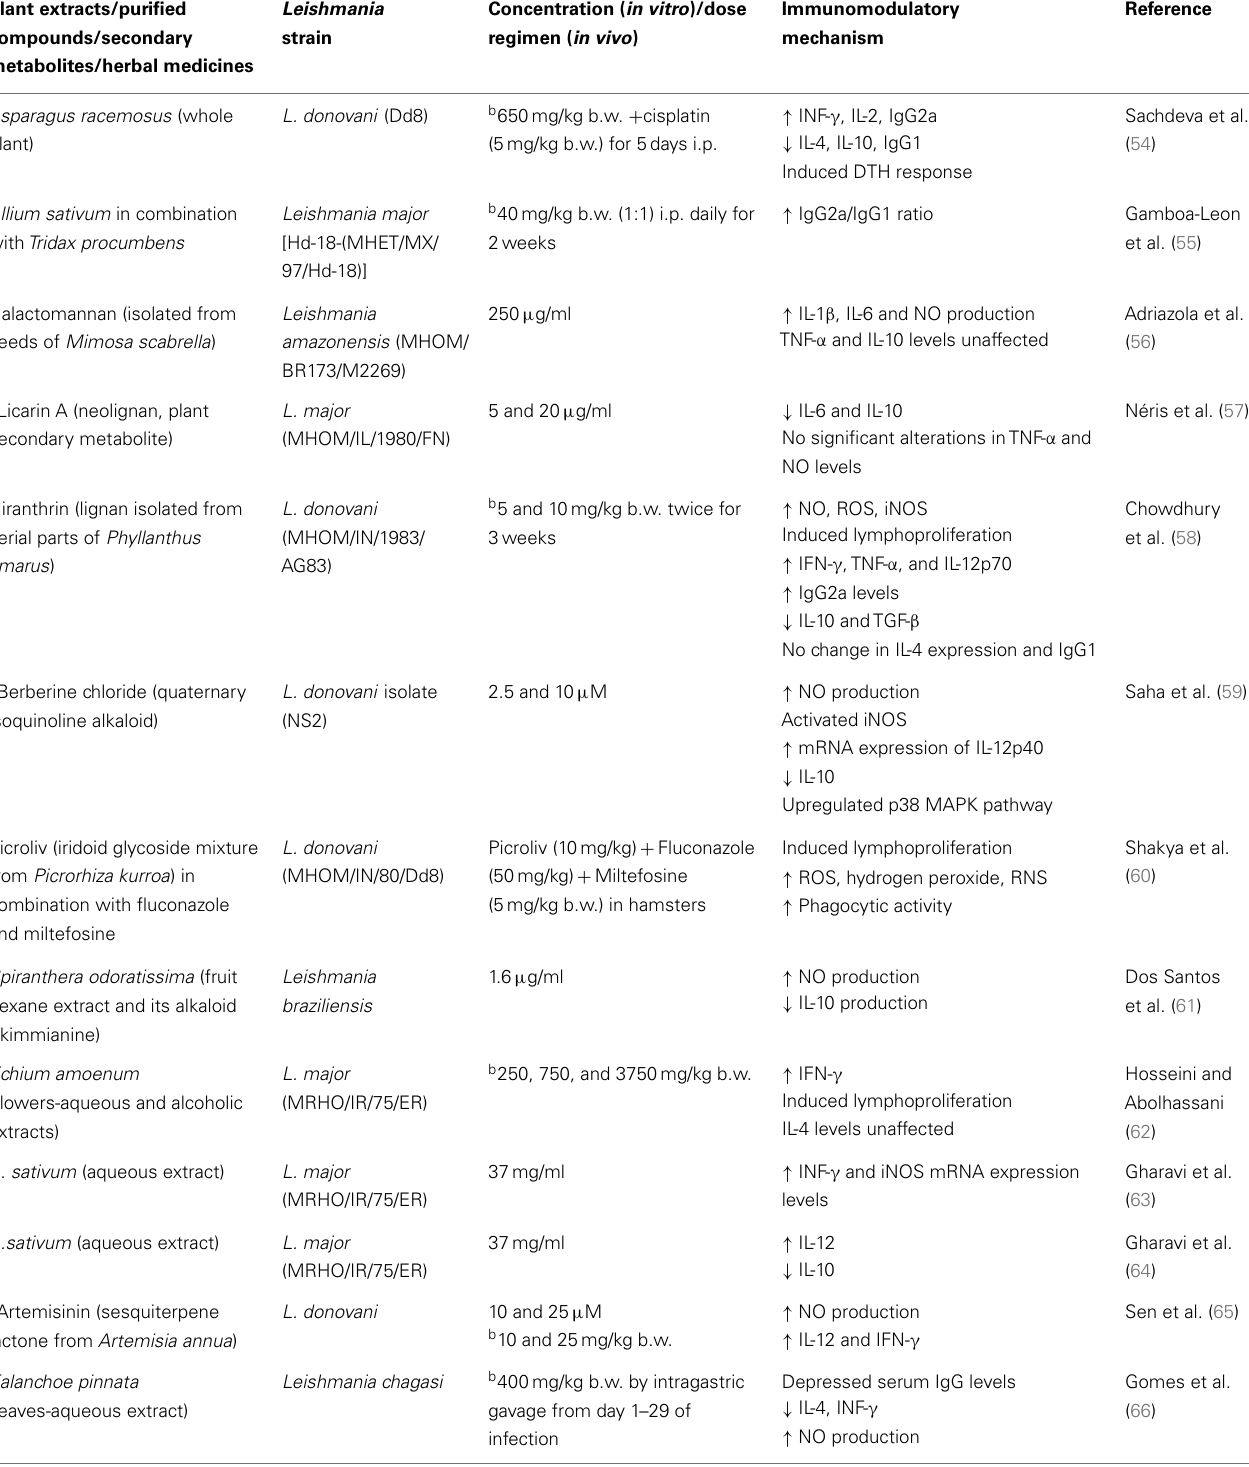
Table 1 | Immunomodulatory antileishmanial plant extracts or purified molecules thereof